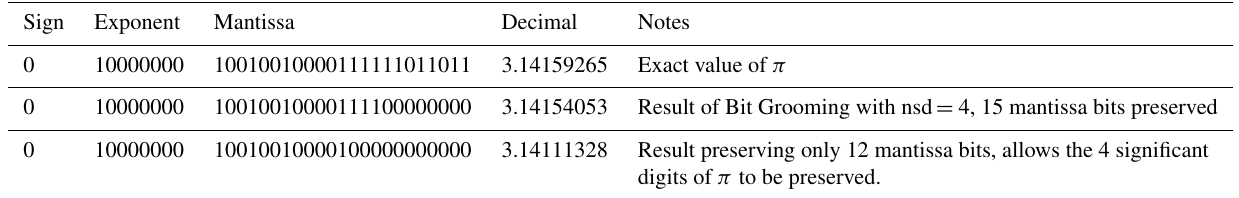
Table 1. Representation of the value of π in IEEE-754 single-precision binary representation (first row) and results preserving 4 significant digits with the Bit Grooming algorithm (second row) or preserving 12 mantissa bits (third row). This table builds on Table 1 in Zender